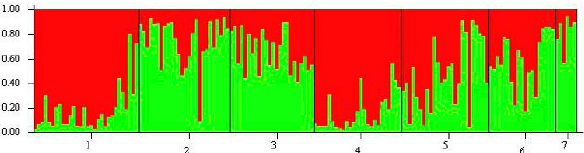
Figure 4. Bayesian structuring analysis. The Y axis indicates the probability-based assignments for the genetic composition of each specimen analyzed (vertical bars). Note (1) Ca2, (2) Ca1, (3) AF, (4) TZ, (5) UZ, (6) AM, (7) Rest (including specimens from Canguare- tama and Tamandaré) . For a description of the sites, see Table 1.